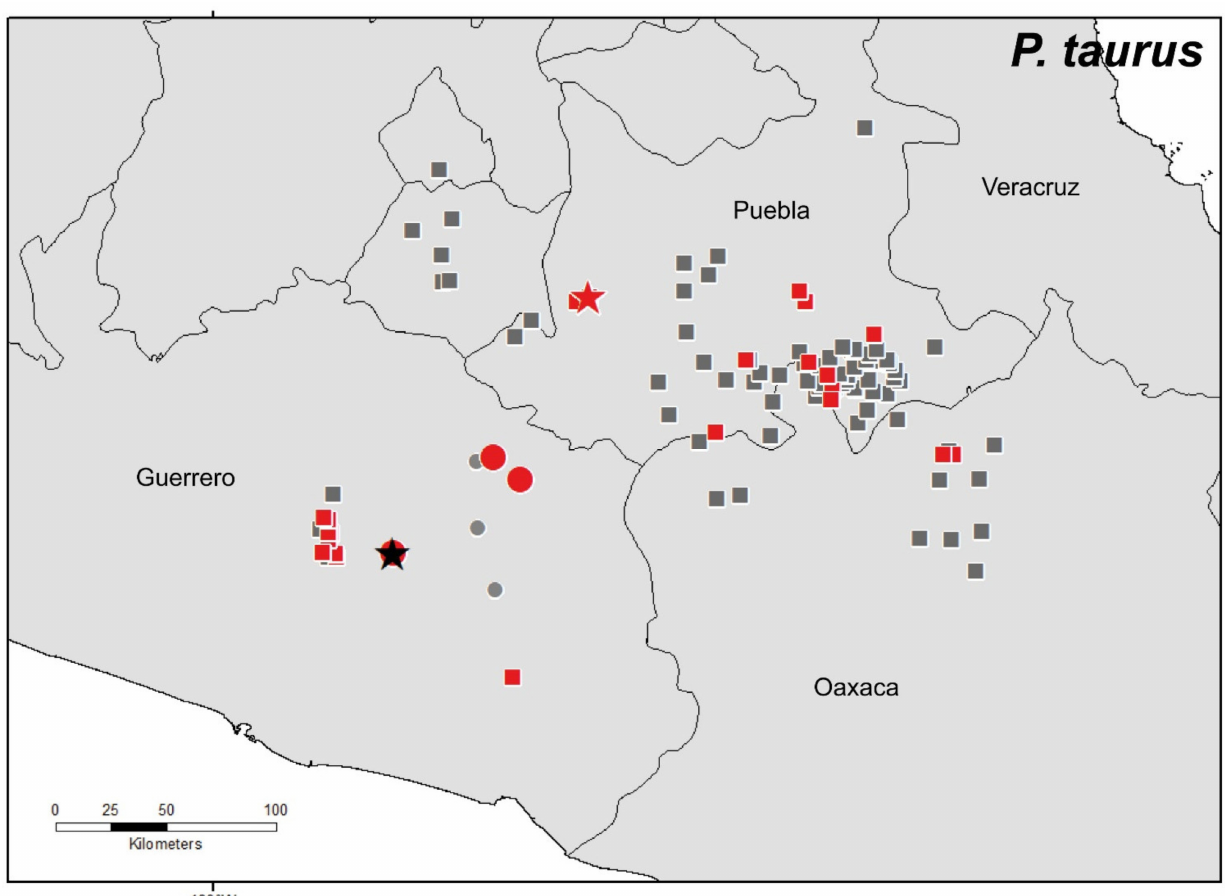
Figure 18. Map showing distributional records of Phrynosoma taurus . Red squares = genetically confirmed records of P. t. taurus ; red circles = genetically confirmed records of P. t. sherbrookei ; gray circles and squares = records that have not been genetically confirmed; black star = type locality of P. sherbrookei ; red star = type locality of P. taurus